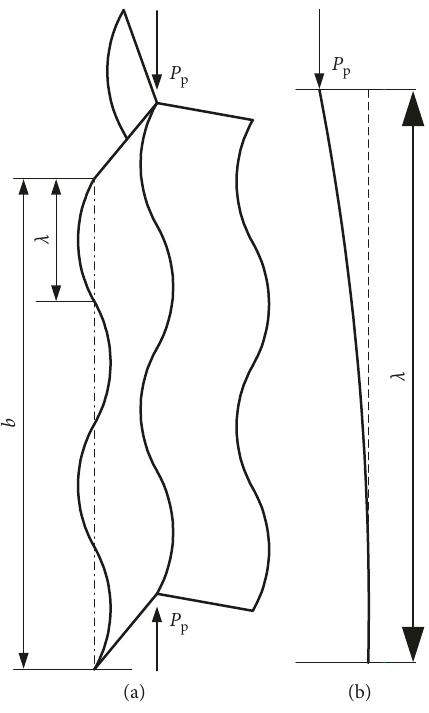
Figure 5: Elastic buckling model for the Y model of honeycombs. (a) Ideal buckling model. (b) Real elastic deformed style.